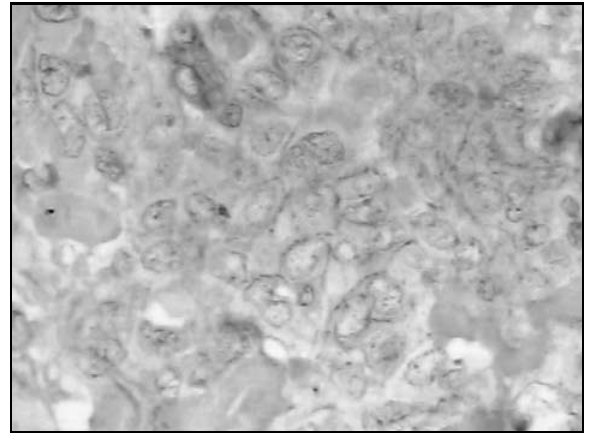
Figura 5 – P-glicoproteína : expressão membranosa em osteossarcoma (IH 400x)